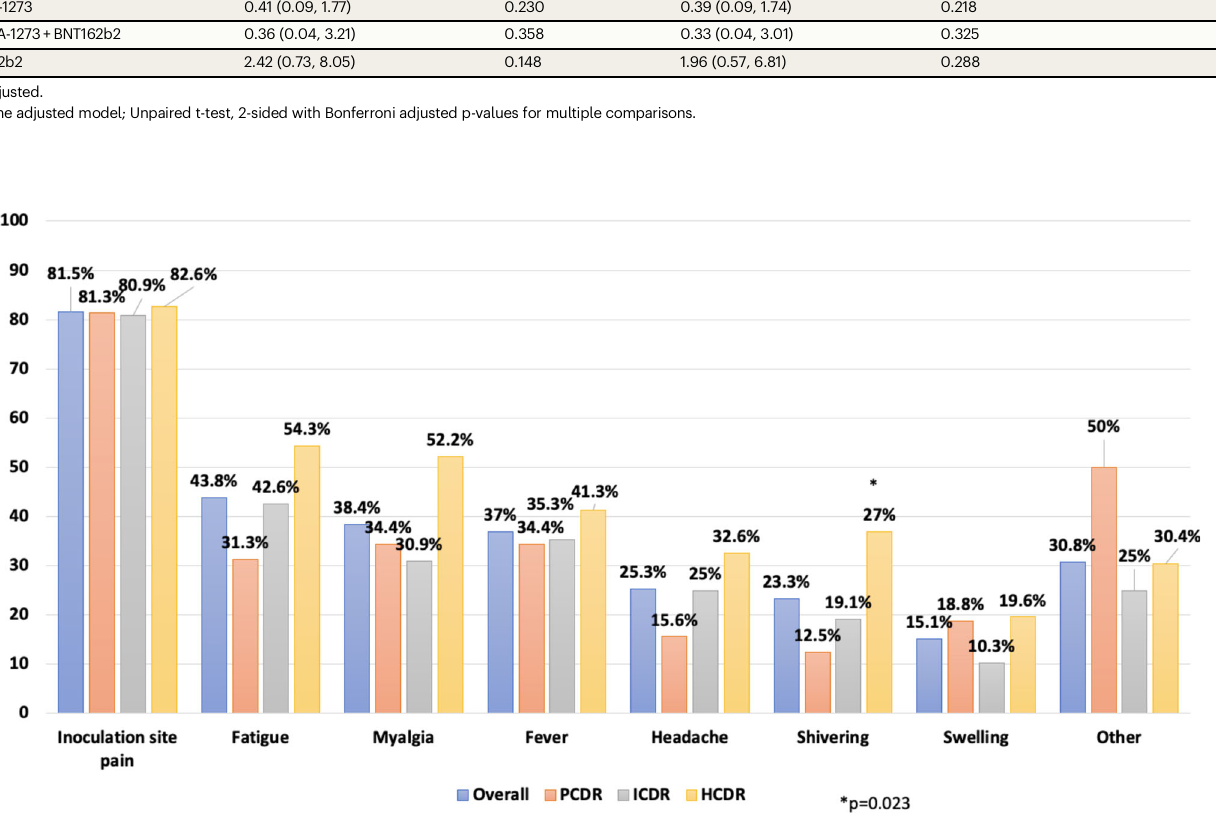
ICDR Intermediate CD4 count recovery, HCDR High CD4 count recovery. Source data are provided as a Source Data fi le.